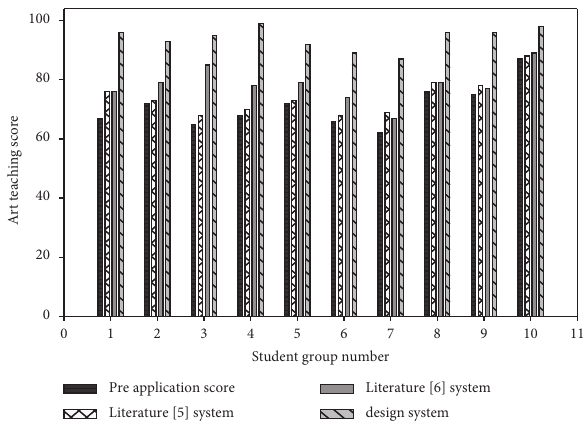
Figure 8: Improvement effect of online teaching system for art students.